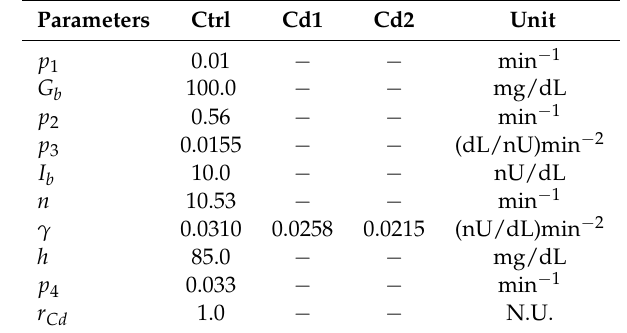
Table 5. Parameters values fitted for the control group as well as groups Cd1 and Cd2 at PND21 (considering Hypothesis 3.1 for both groups).